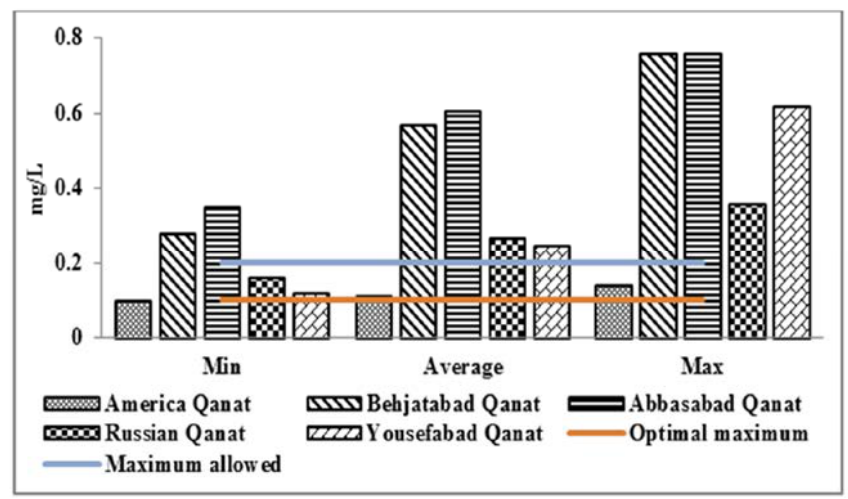
Fig. 6: Phosphate level of and its comparison with the WHO and the National Standard of Iran